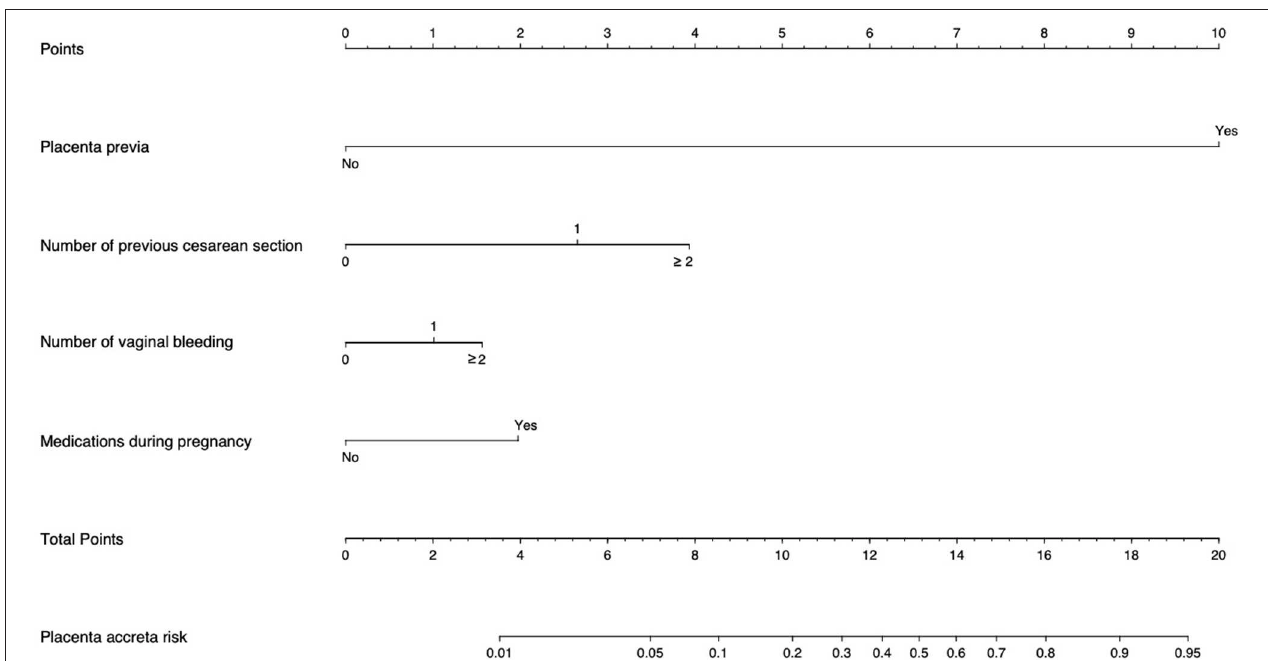
FIGURE 1 | Placenta accreta Risk Assessment Tool. “Points” refers to point for the individual risk factor and add together to the “Total points.” “Placenta accreta risk” was calculated according to the ‘’Total points.” Example: For a patient with one previous CS (score = 2.6), with one vaginal bleeding (score = 1), with placenta previa (score = 10), and medication during pregnancy (score = 1.9), the total score is 15.5 corresponding to a 74% risk of placenta accreta (PA).